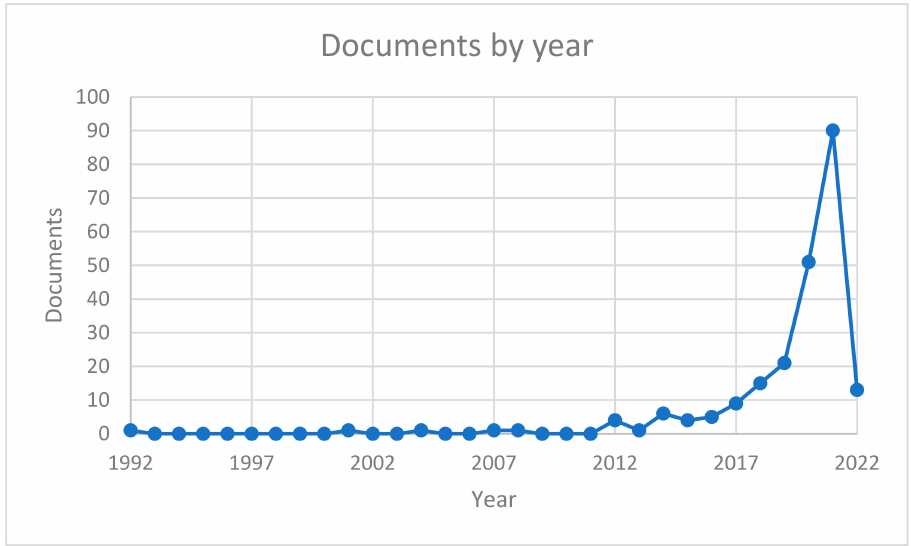
Figure 1. Trend of documents per